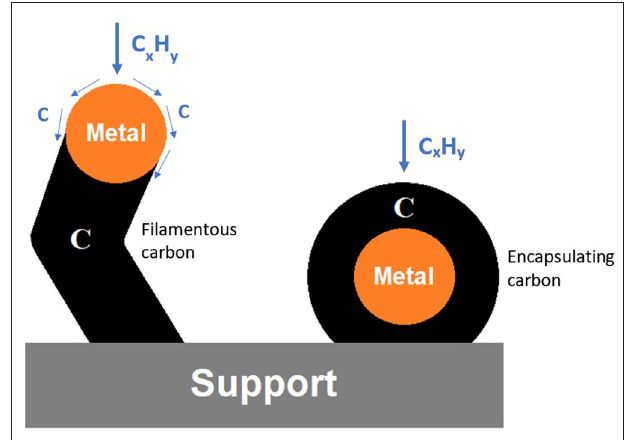
FIGURE 3 | Illustrative representation of the most common carbon deposit types observed in supported metal catalysts after